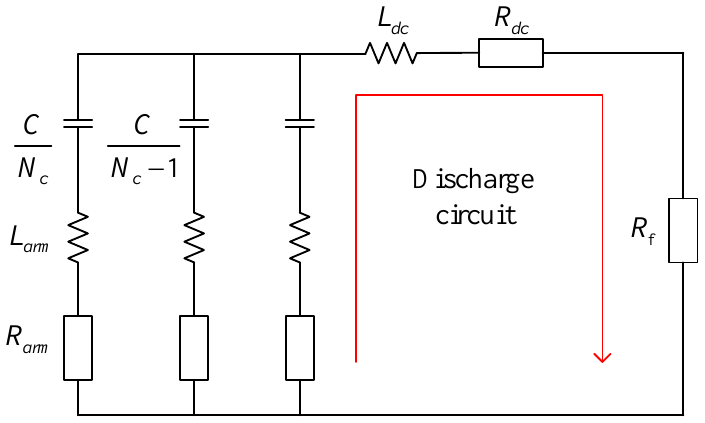
Figure 6. CHBFBSM-MMC equivalent circuit before the sub-module is blocked.